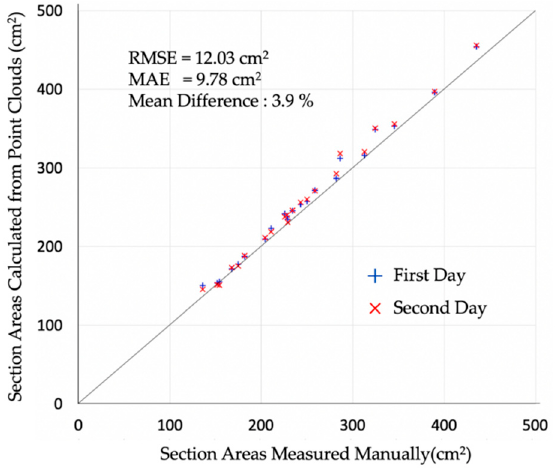
Figure 21. Comparison of measured and calculated section areas.